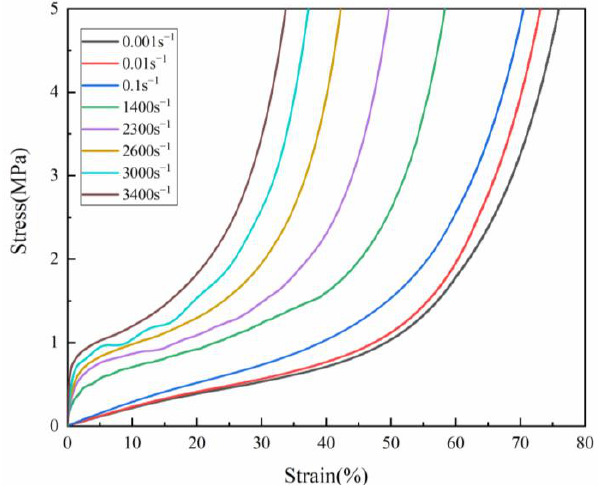
Figure 8. The stress–strain curves of 600 kg/m 3 PUMEs with different strain rates at 23 °C ± 2 °C.